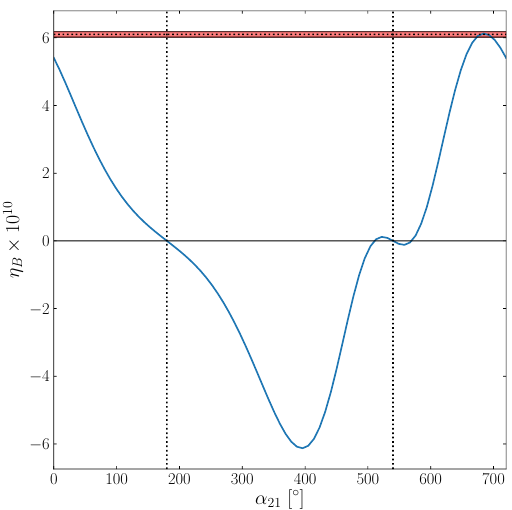
Figure 4 . The baryon asymmetry with M 1 = 3 : 05 10 10 GeV and CP violation provided solely by (cid:2) (cid:11) 21 (corresponding to (cid:14) = (cid:11) 31 = 0 (cid:14) ). The red band indicates the 1 (cid:27) observed values for (cid:17) B with the best-(cid:12)t value indicated by the horizontal black dotted lines. Here we show the baryon asymmetry against (cid:11) 21 with exact CP -invariance at (cid:11) 21 = 180 (cid:14) and 540 (cid:14) (vertical black dotted